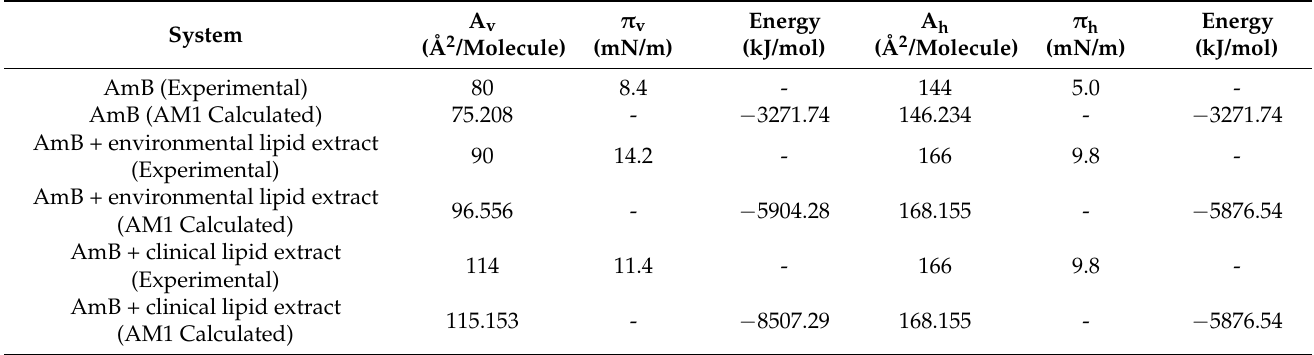
Table 2. Values of molecular areas in horizontal (A h ) and vertical position (A v ) of AmB and AmB + lipid extracts with their corresponding surface pressures in horizontal ( π h ) and vertical ( π v ) positions, compared to the values obtained by molecular optimization to an AM1 level of theory using SPARTAN Pro Software.